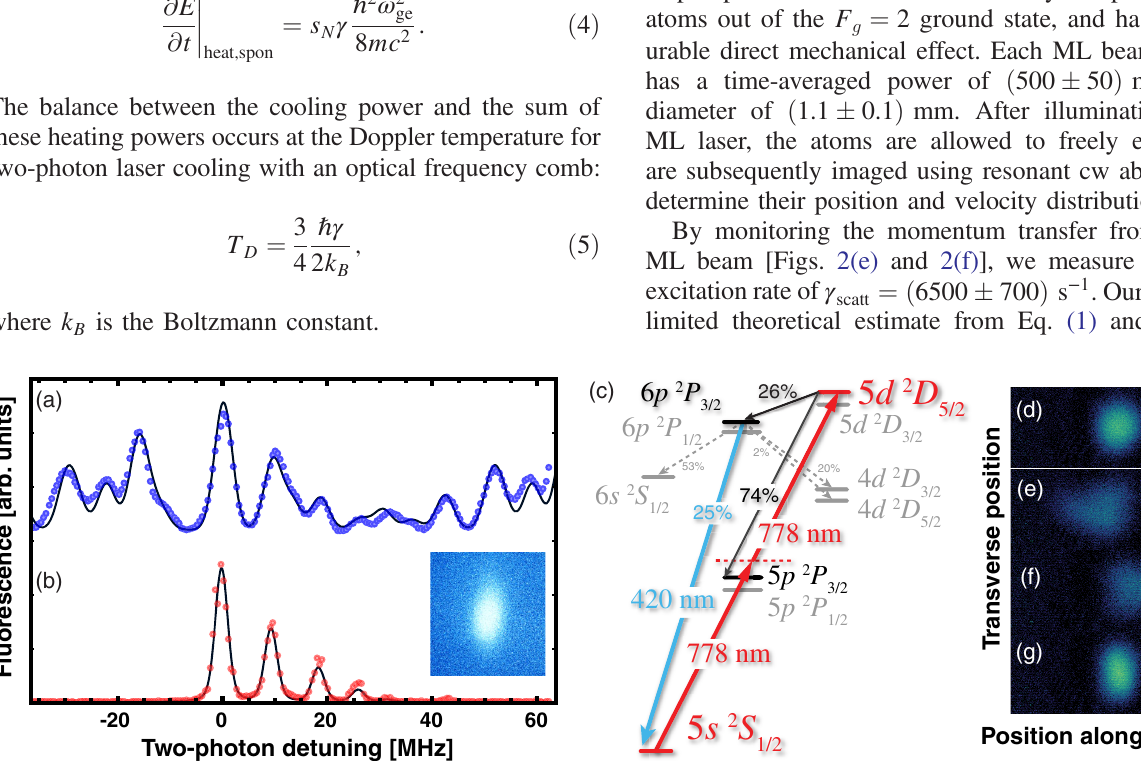
FIG. 2. Laser-induced fluorescence spectrum of the 5 S → 5 D two-photon transition driven by an optical frequency comb. (a) Spectrum from a natural abundance vapor cell and (b) a 85 Rb cw MOT and collected 420-nm light (inset). Solid curves are ¼ 81 . 14 MHz on the horizontal axis. theory fitted for (a) Gaussian and (b) Voigt line shapes. These spectra repeat with a period of f r (c) Relevant levels of rubidium. (d) – (g) Absorption images of the atom cloud after free expansion following (d) no ML illumination, (e) ML illumination from the right, (f) left, and (g) both directions, detuned to the red of resonance. Mechanical forces are evident in (e) and (f), and the narrowing of the velocity distribution in the horizontal direction in (g) is the hallmark of